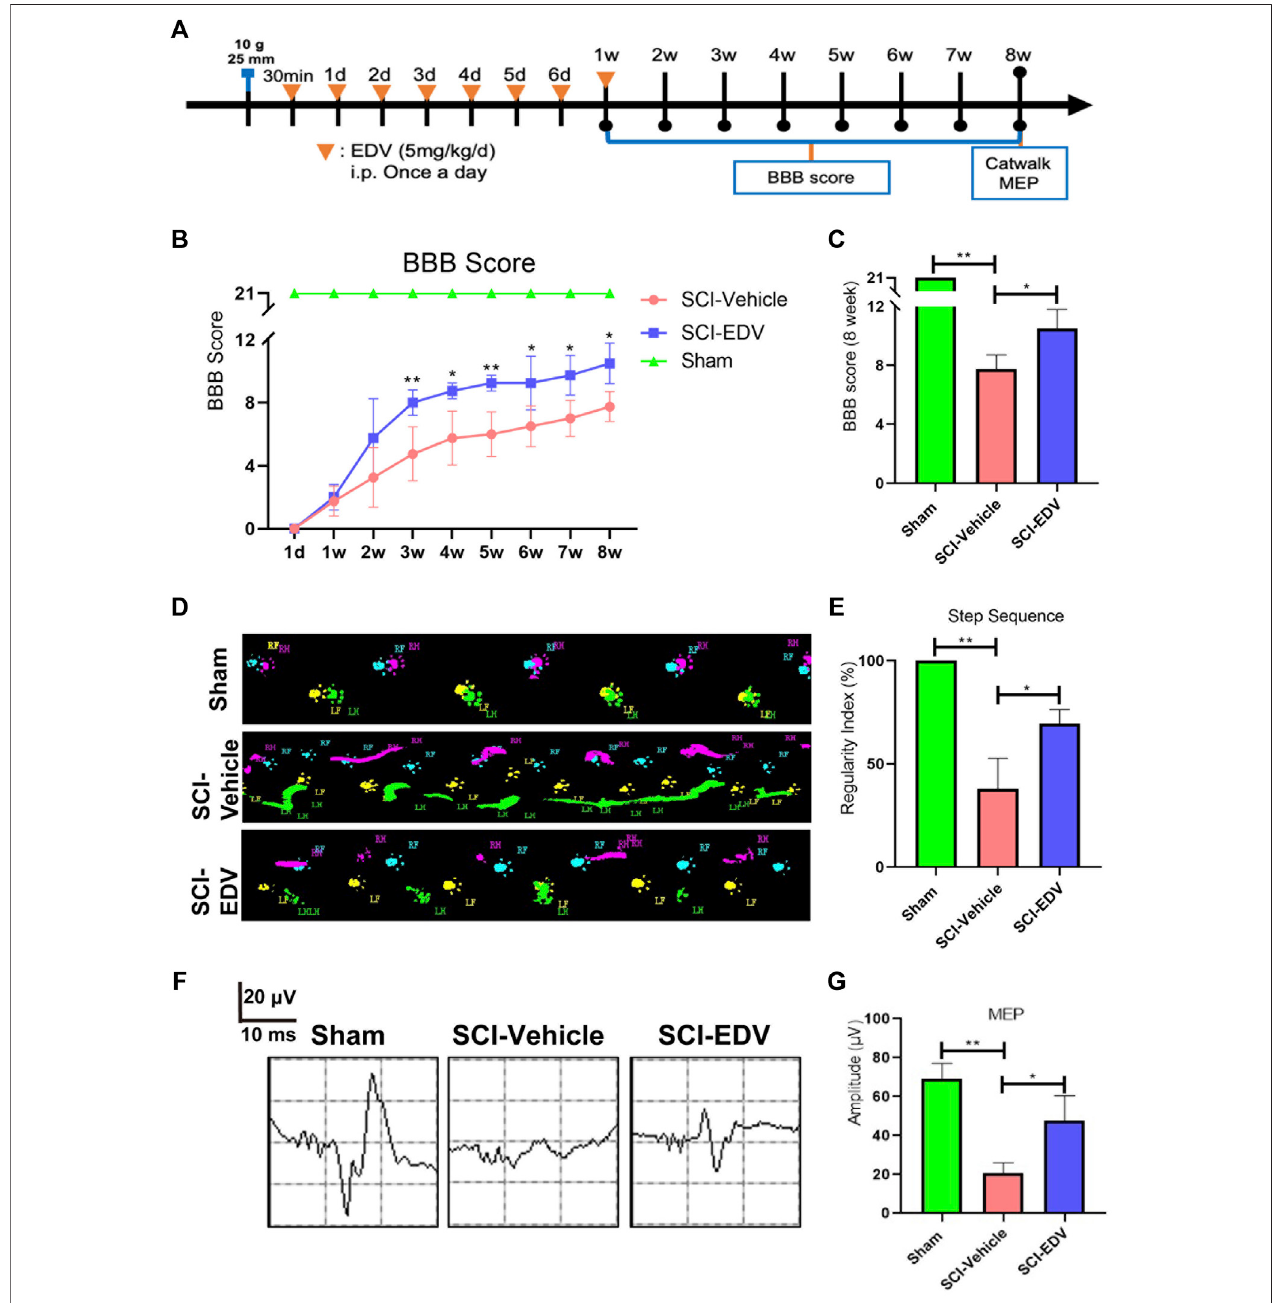
FIGURE 7 | Edaravone promotes motor functional recovery after spinal cord injury. (A) Timeline of the experiment. 30 min after SCI, rats received EDV (5 mg/kg/ day)continuouslyfor7 days.BBBscoreswereassessedeveryweekfor8 weeks.Inaddition,CatwalkandMEPdetectionwereperformedat8 weeksafterSCI. (B) BBB locomotor scores were assessed for hindlimbs, up to 8 weeks post injury. (C) BBB scores at 8 weeks were compared. (D) Print views were recorded at 8 weeks post injurybytheCatWalkXTsystem. (E) Regularityindex(%index)ispresentedasanoverallmeasureofthedegreeofthenormalstepsequence. (F) Electrophysiology of MEP at 8 weeks post spinal cord injury. (G) MEP amplitudes of each group were quanti fi ed. Data are expressed as the mean ± standard deviation. Statistical signi fi cance was determined by one-way ANOVA with Tukey ’ s post hoc test. * p < 0.05; ** p < 0.01, n = 3.